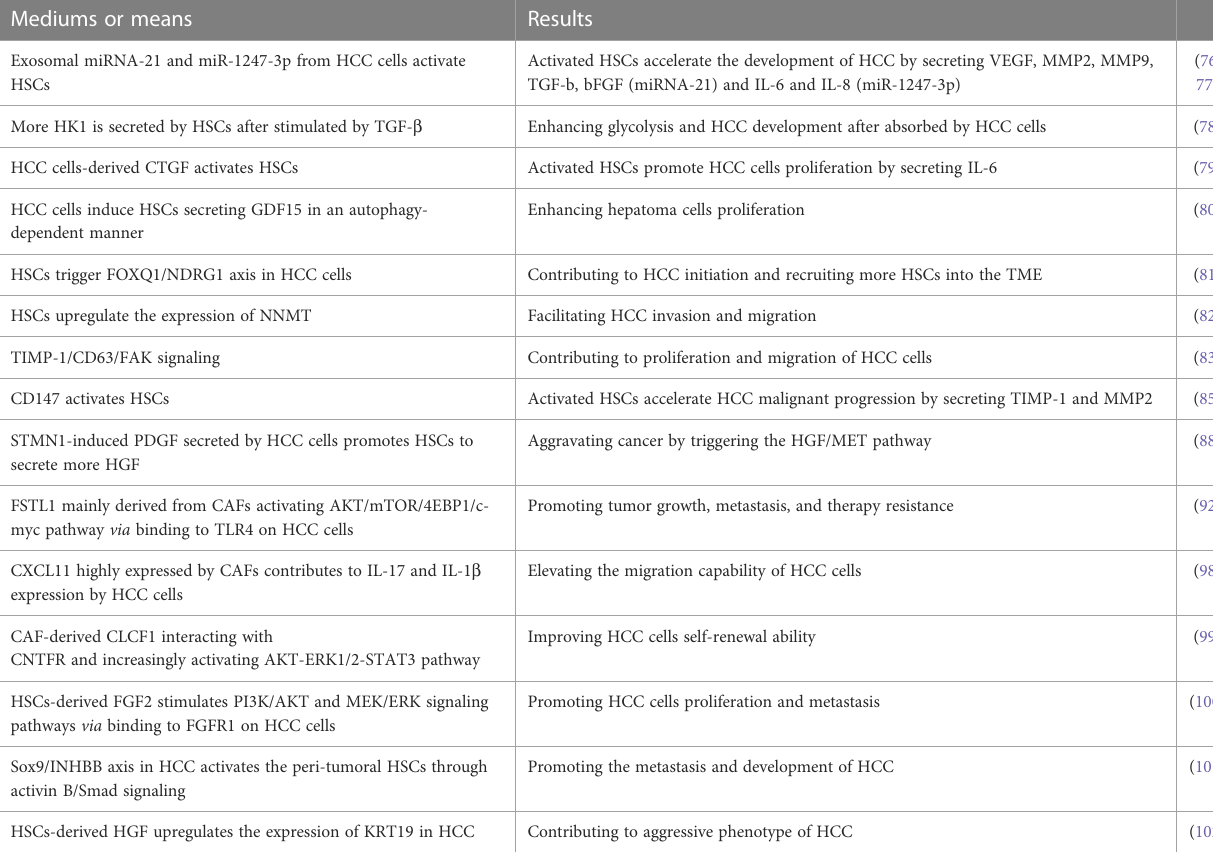
TABLE 1 The crosstalk between HCC cells and HSCs or